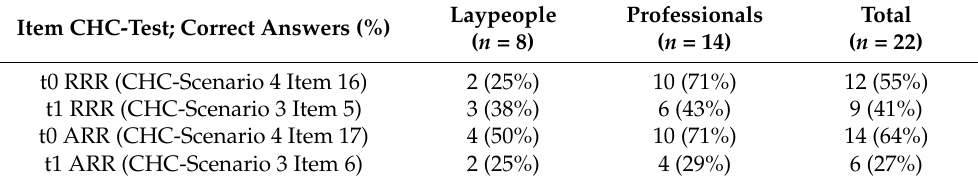
Table 4. Evaluation of the knowledge